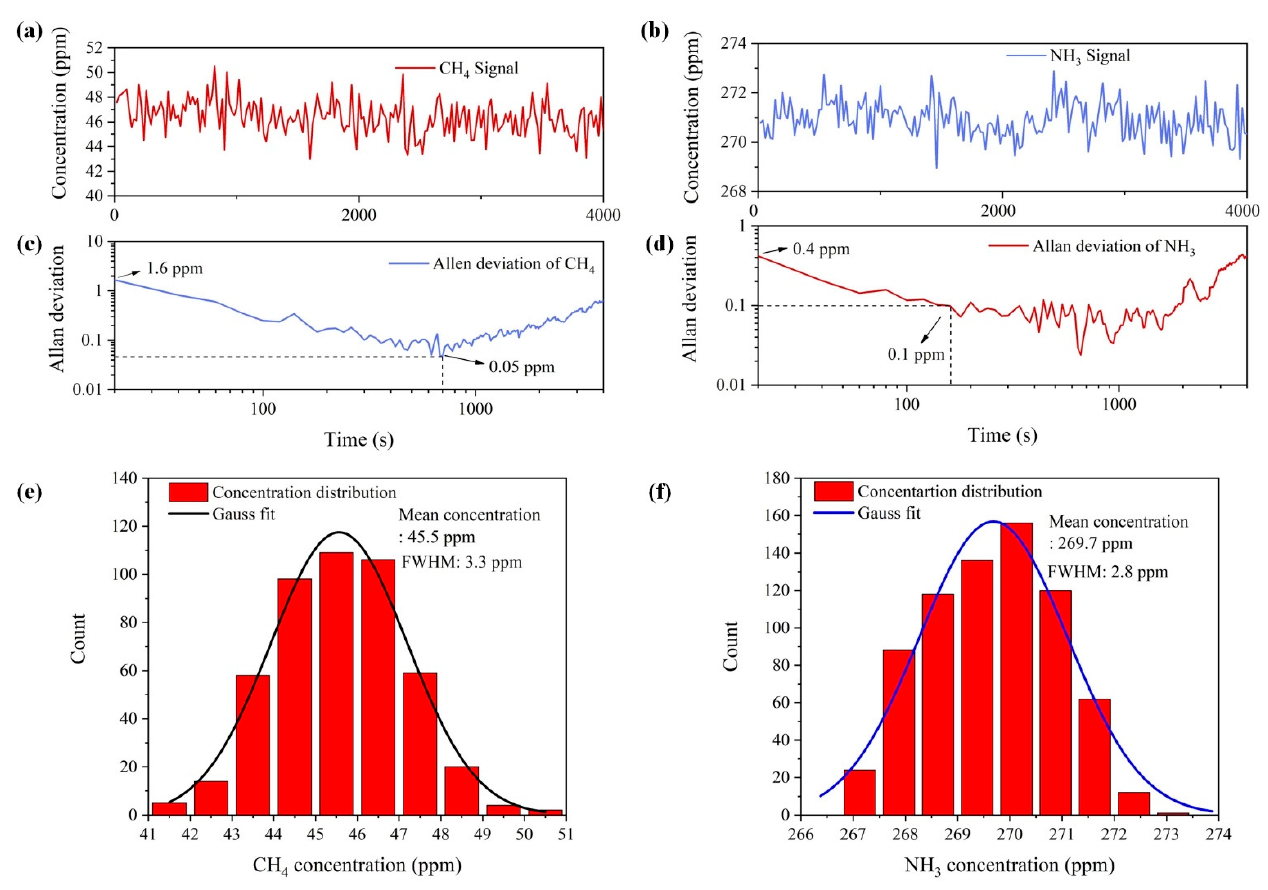
Figure 9. ( a ) Continuous measurement of CH 4 for 4000 s. ( b ) Continuous measurement of NH 3 for 4000 s. ( c ) Allan deviation plots of CH 4 as a function of integration time. ( d ) Allan deviation plots of NH 3 as a function of integration time. ( e ) Concentration distribution of the retrieved CH 4 with a concentration of 46 ppm with Gaussian profile fit. ( f ) Concentration distribution of the retrieved NH 3 with a concentration of 270 ppm with Gaussian profile fit.